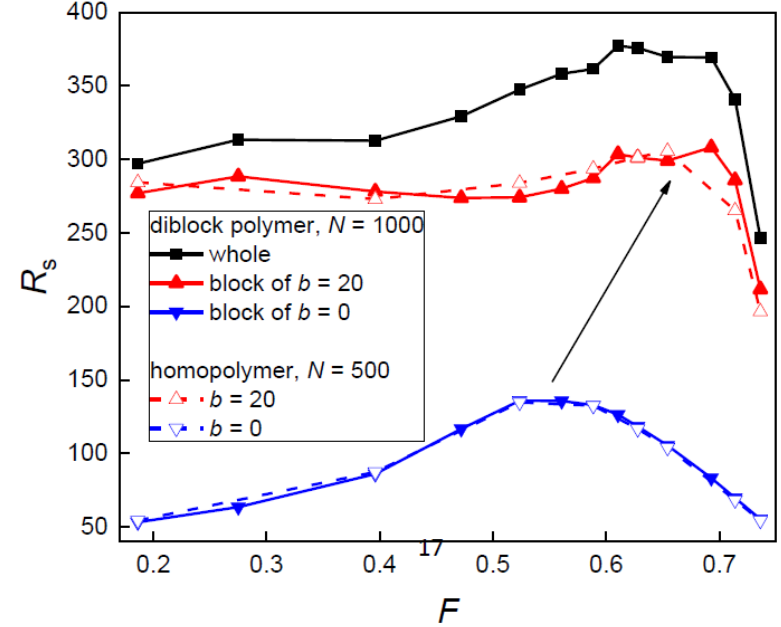
Figure 7. The axial span of a diblock chain, its blocks and homopolymer chains corresponding to the blocks as a function of the filling fraction of posts F for constant passage width w =